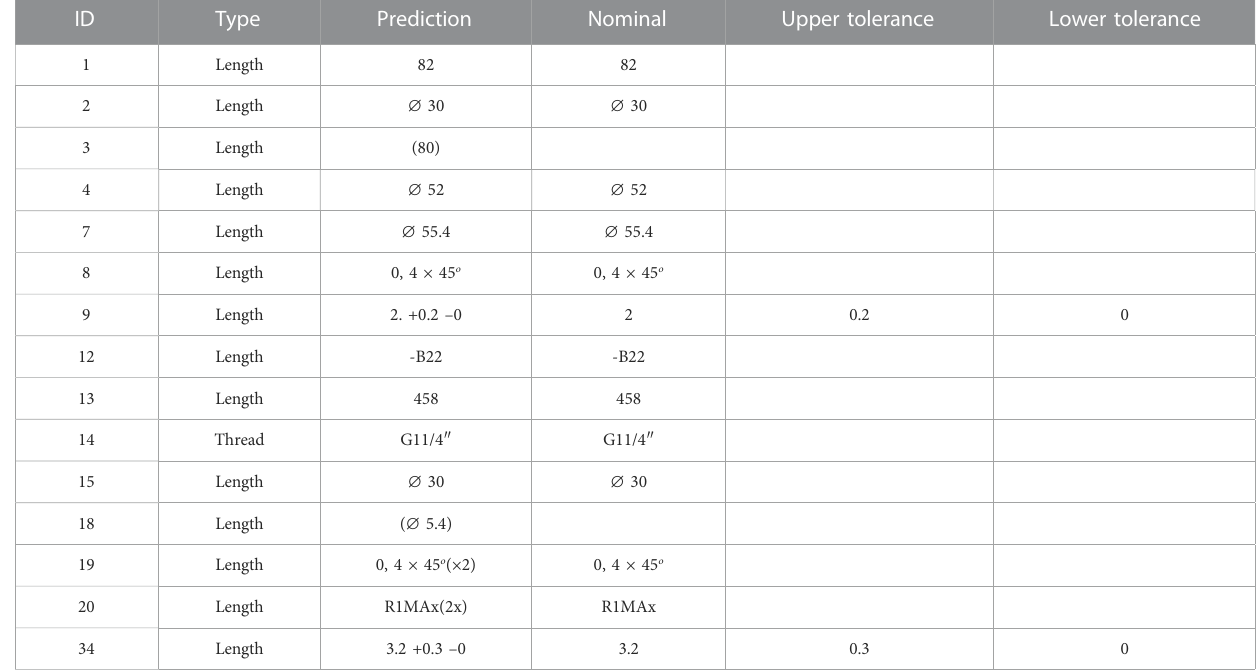
TABLE 2 Results from the dimension pipeline. Table with results after postprocessing. Red rows are fl agged dimensions with potential missing characters. The table expresses the ID of the prediction, type of measurement, predicted text, nominal value, and lower and upper